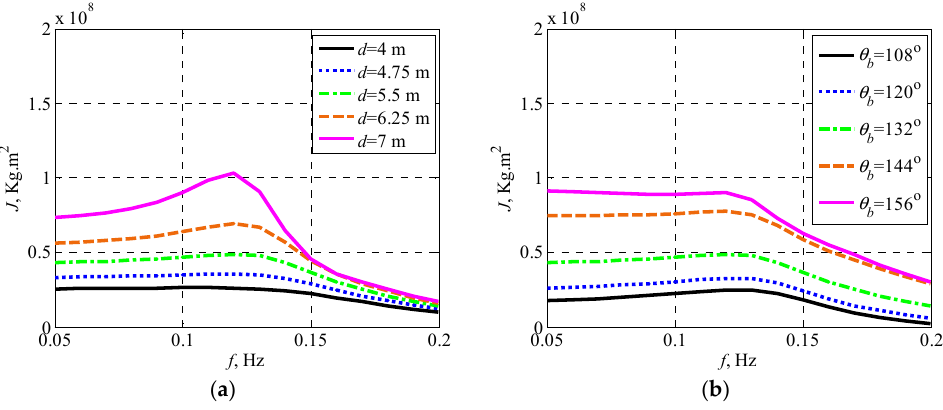
Figure 4. Added inertia as a function of wave frequency at different floating states: ( a ) for fixed beak angle at θ b = 144°; and ( b ) for fixed depth of rotation axis at d = 5.5 m.